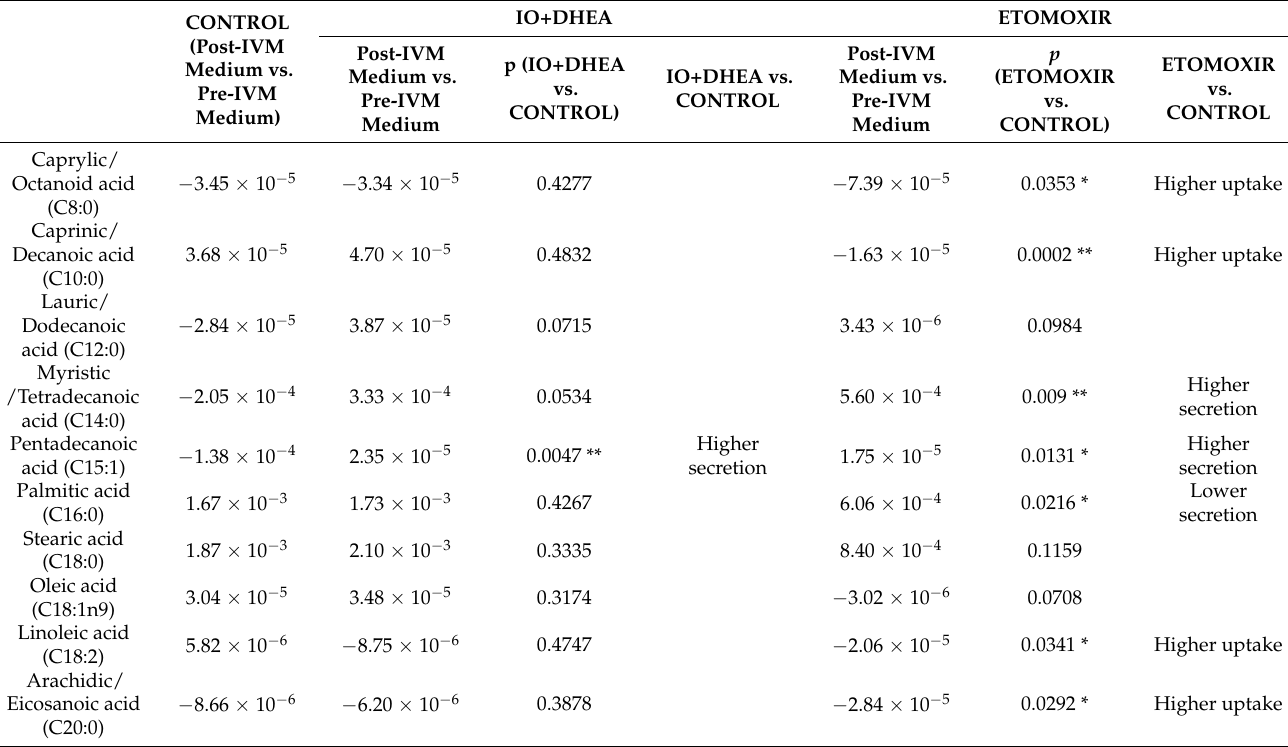
Table 2. Fatty-acid-concentration changes detected in the maturation medium (mean values). The positive values of concentration indicate higher concentration after IVM when compared to the medium before IVM (COCs secreted selected FA). The negative values of concentration indicate lower concentration after IVM when compared to the medium before IVM (COCs collected selected FA). Values are significantly different when * p ≤ 0.05 or ** p ≤